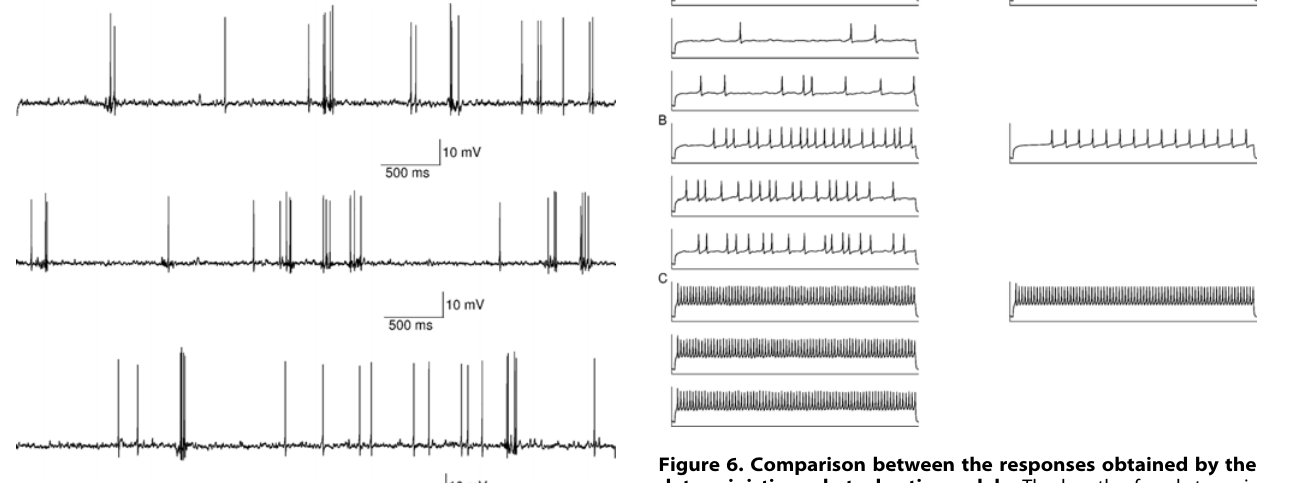
generate spontaneous activity when tonic inhibition of Golgi cells is reduced.